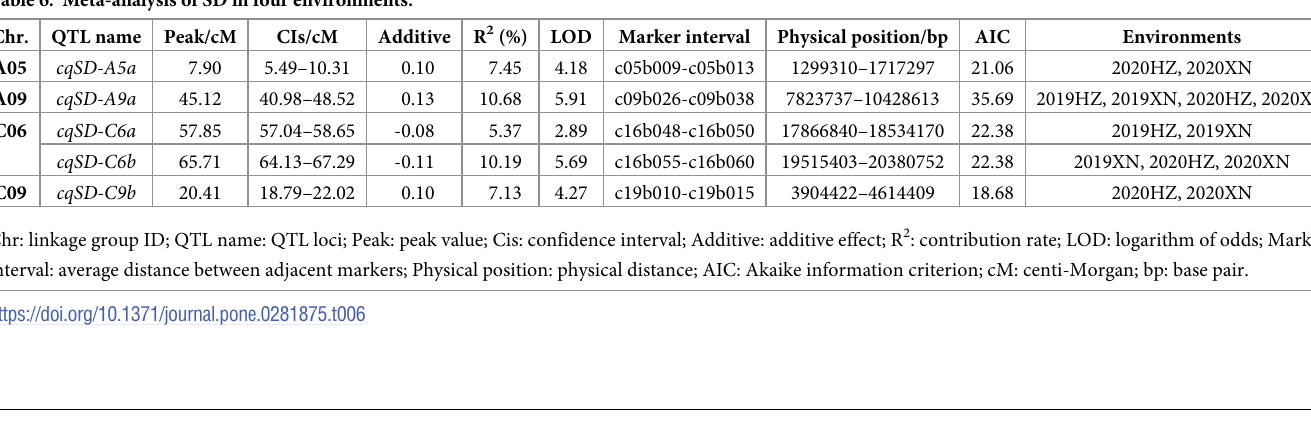
Table 6. Meta-analysis of SD in four